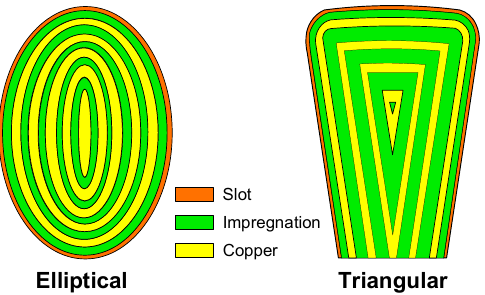
Figure 24. Multi-layered winding thermal modelling strategies.